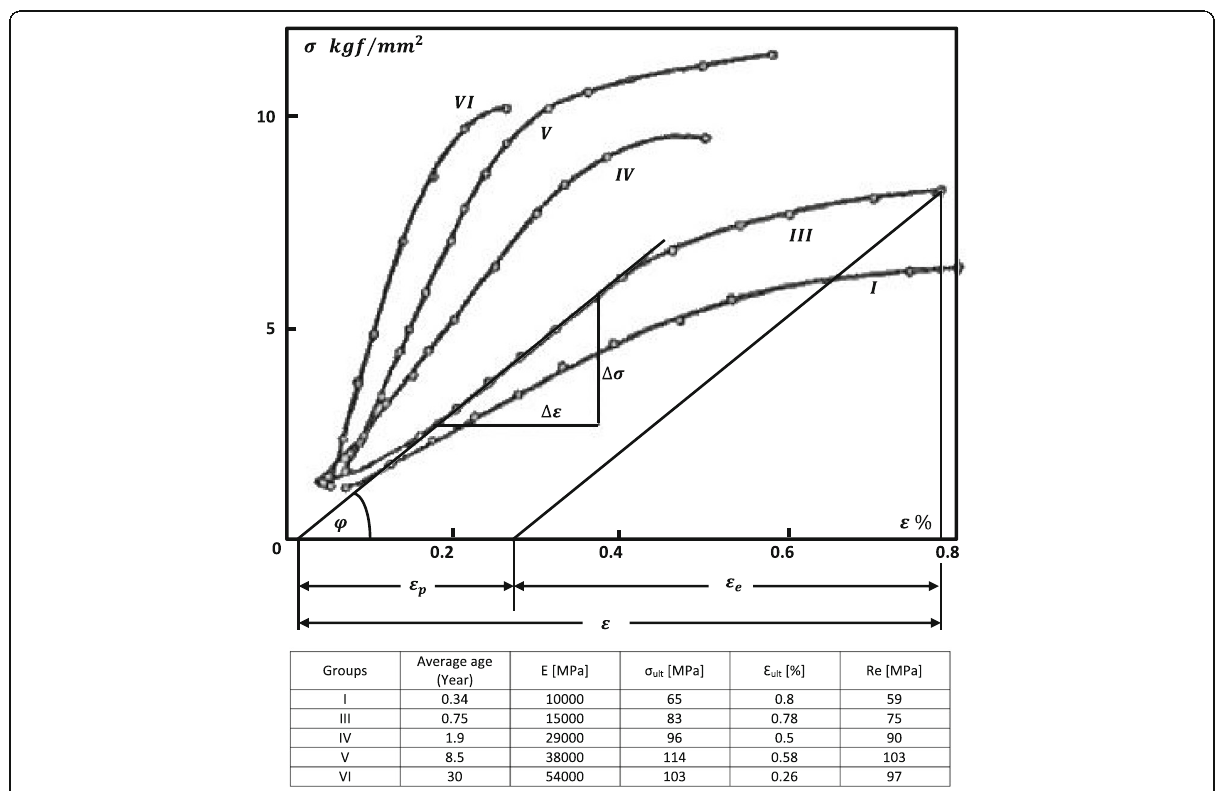
Fig. 5 Stress – strain curves of compact bone (Vinz 1975) and the values read from the curves: The data are from seven age groups with the following average group ages in years: I) 0.05, II) 0.34, III) 0.75, IV) 1.9, V) 8.5, VI) 30 and VII) 80. The values of the elongation at break ε ult from this